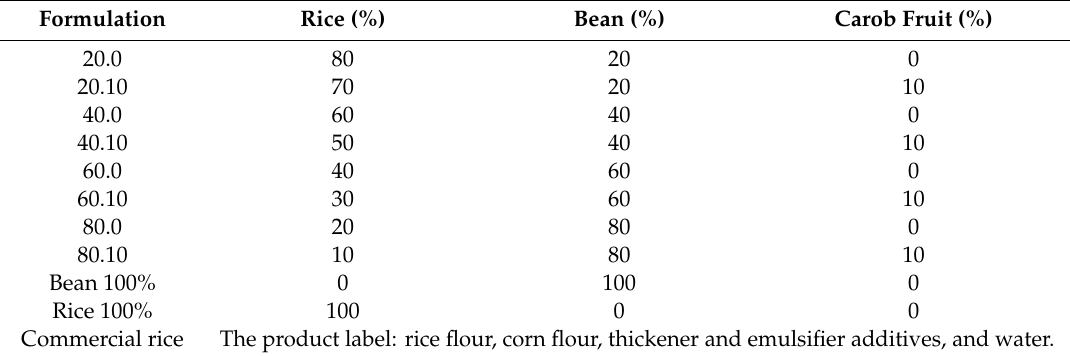
Table 1. Codification and formulation of the di ff erent rice / bean-based fettuccine pastas fortified with carob fruit flours and the commercial control pasta (external